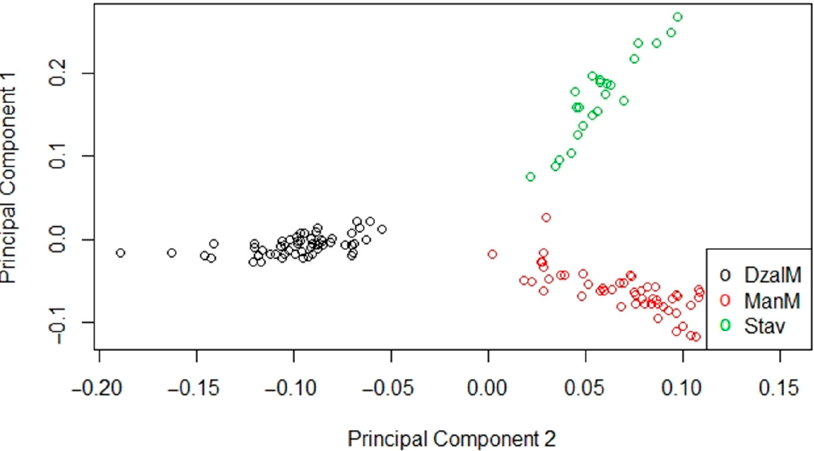
Figure 2. Breed purity PCA of Jalgin merino (DzalM) compared with the Manych merino (ManM) and Stavropol sheep (Stav).